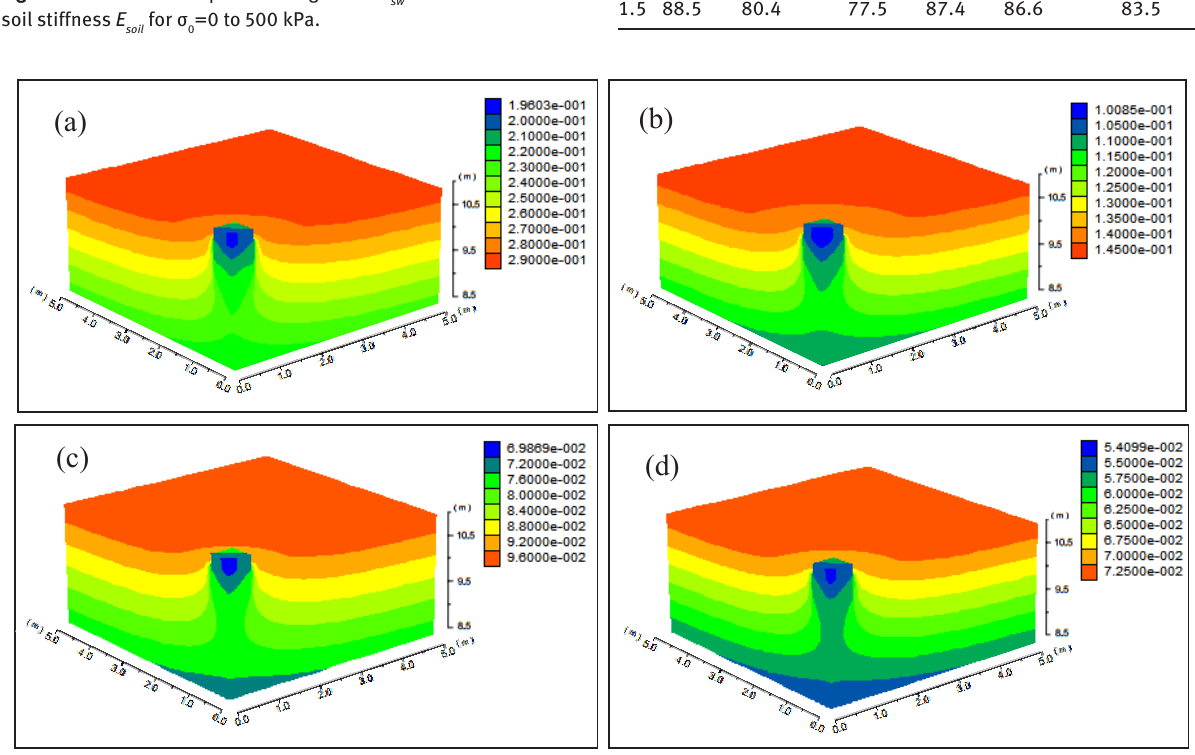
of width B=1m with sw